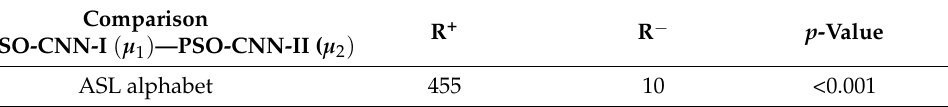
Table 17. Wilcoxon test results for the ASL alphabet.